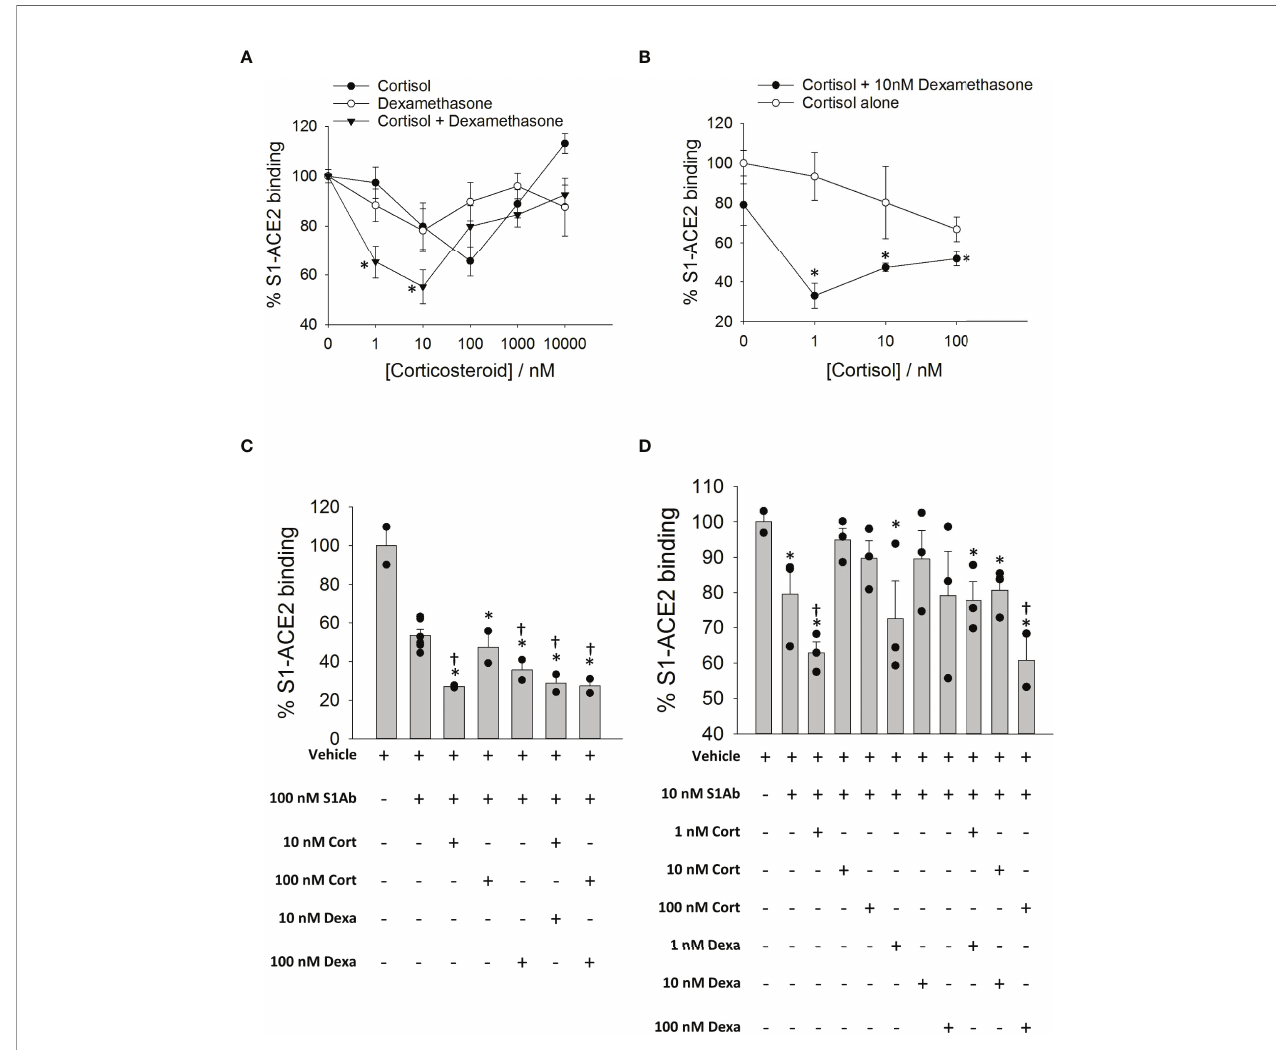
FIGURE 5 | The effects of cortisol and dexamethasone on the binding of SARS-CoV-2 S1 to ACE2. (A) Plot showing a dose response on SARS-CoV-2 S1-ACE2 interaction in the presence of increasing concentration of glucocorticoids (cortisol, dexamethasone or a mixture of cortisol and dexamethasone). Each data plot was normalized to vehicle (100% S1-ACE2 binding). Data presented as mean ± standard error (n = 2-6). * P < 0.05 vs cortisol or dexamethasone alone at same concentration (1-way ANOVA). (B) Plot showing a dose response on SARS-CoV-2 S1-ACE2 interaction in the presence of increasing concentration of cortisol ± 10 nM dexamethasone. Each data plot was normalized to vehicle (100% S1-ACE2 binding). Data were measured in at least two independent replicates and are presented as mean ± standard error. * P < 0.05 vs cortisol alone at same concentration (1-way ANOVA). (C, D) Bar plot showing the effect of cortisol or dexamethasone on the inhibition of SARS-CoV-2 S1-ACE2 interaction by anti-SARS-CoV-2 S1 antibody (10nM or 100nM). Data are normalized to vehicle (100% S1-ACE2 binding). Data presented as mean ± standard error (n = 2-6). * P < 0.05 vs vehicle (1-way ANOVA); † P < 0.05 vs S1Ab alone (1-way